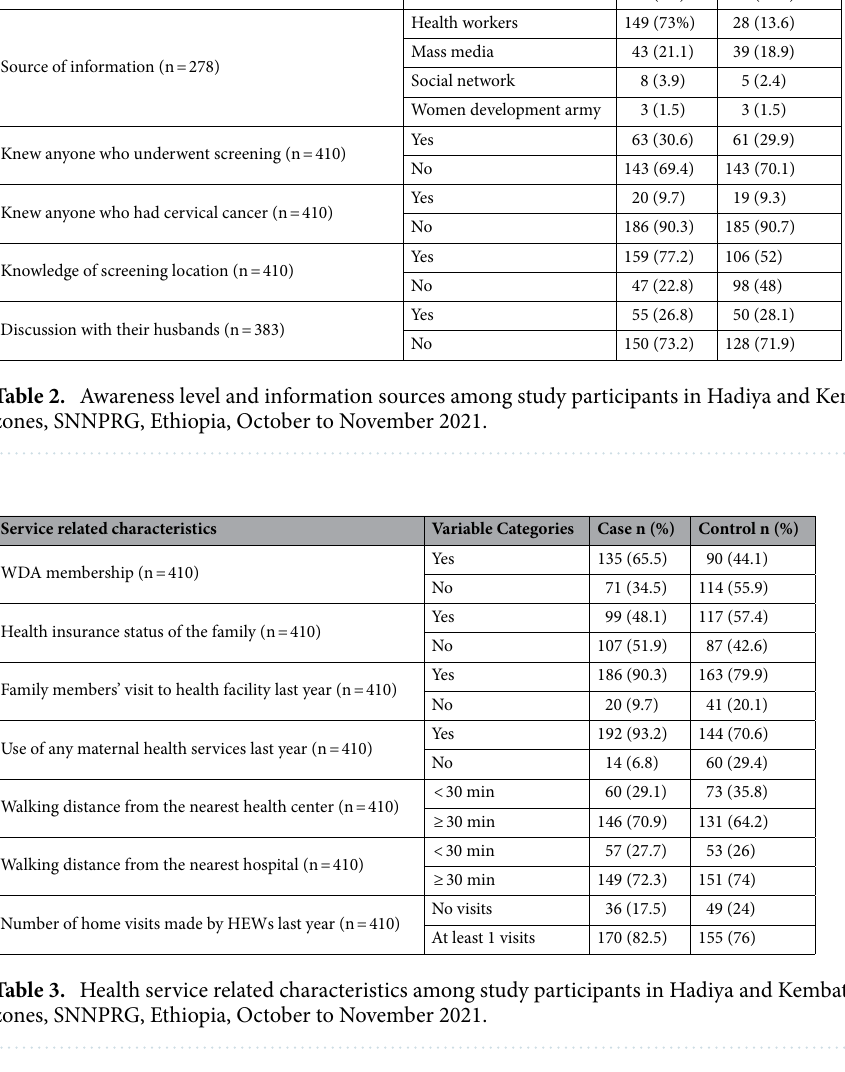
Table 3. Health service related characteristics among study participants in Hadiya and Kembata Tembaro zones, SNNPRG, Ethiopia, October to November 2021.